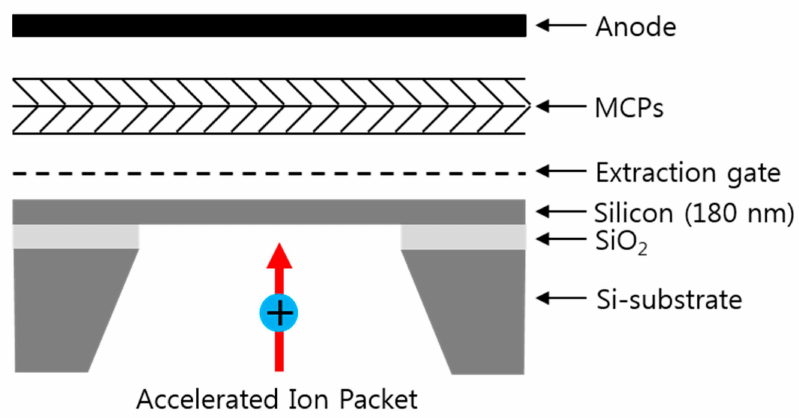
Figure 1. Schematic of the detector, consisting of a 180 nm silicon nanomembrane, an extraction gate, microchannel plates (MCPs), and an anode. Accelerated ions bombard the back side of the nanomembrane and deposit thermal energy on it.